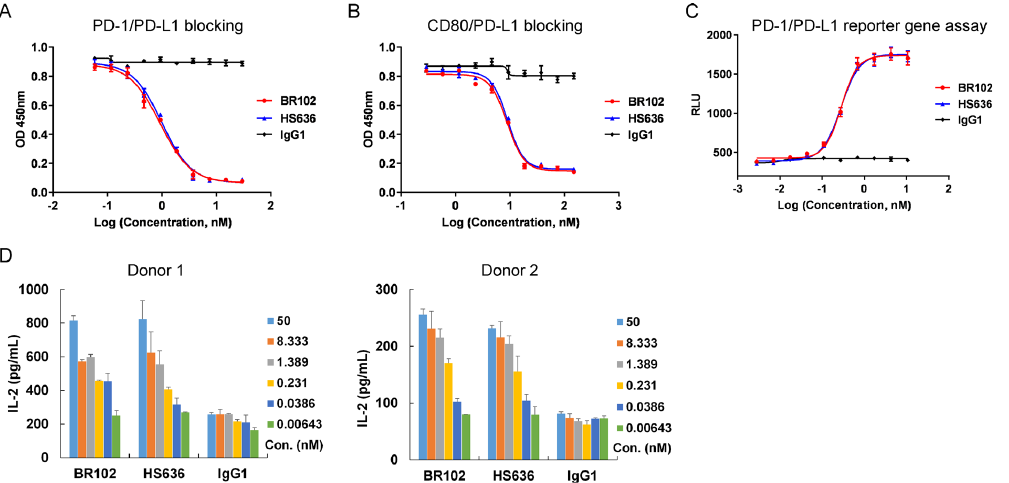
Figure 3. BR102 reversed PD-L1/PD-1 mediated immunosuppression and enhanced T cell activation. BR102 blocked PD-1/PD-L1 interaction ( A ) and CD80/ PD-L1 interaction ( B ) in competition ELISA assays. ( C ) The blockade ability of HS636 on PD-1/PD-L1 signaling was determined by the NFAT reporter gene assay. ( D ) DCs and allogeneic PBMC from 2 donors were co-cultured in the presence of indicated concentrations of BR102 or HS636 for 3 days. IL-2 secretion was analyzed by